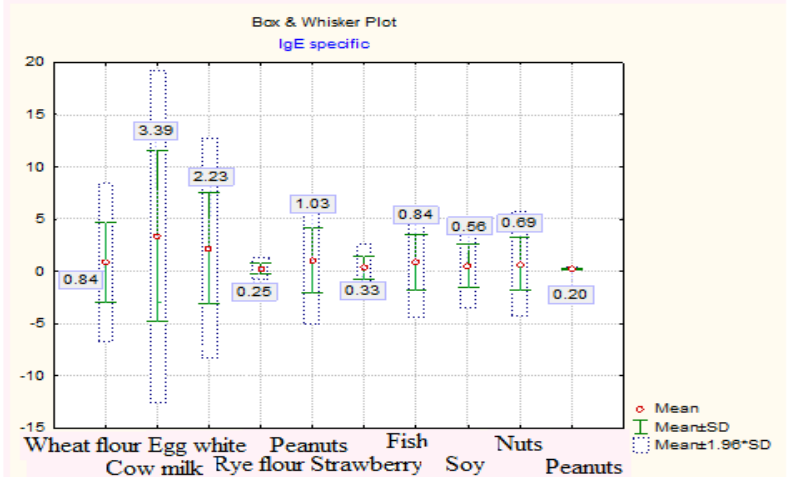
Figure 2. Specific IgE values depending on the type of allergen.